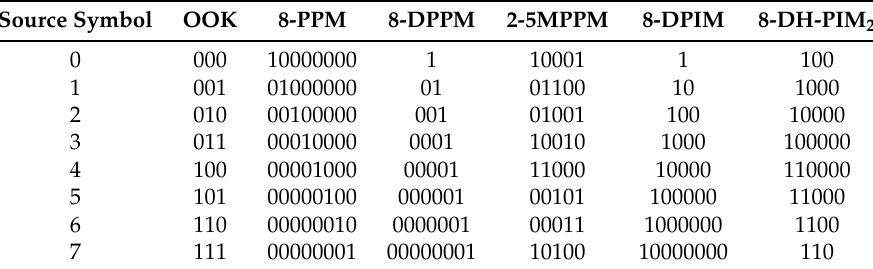
Table 9. Three-bit block representation according to modulation technique.